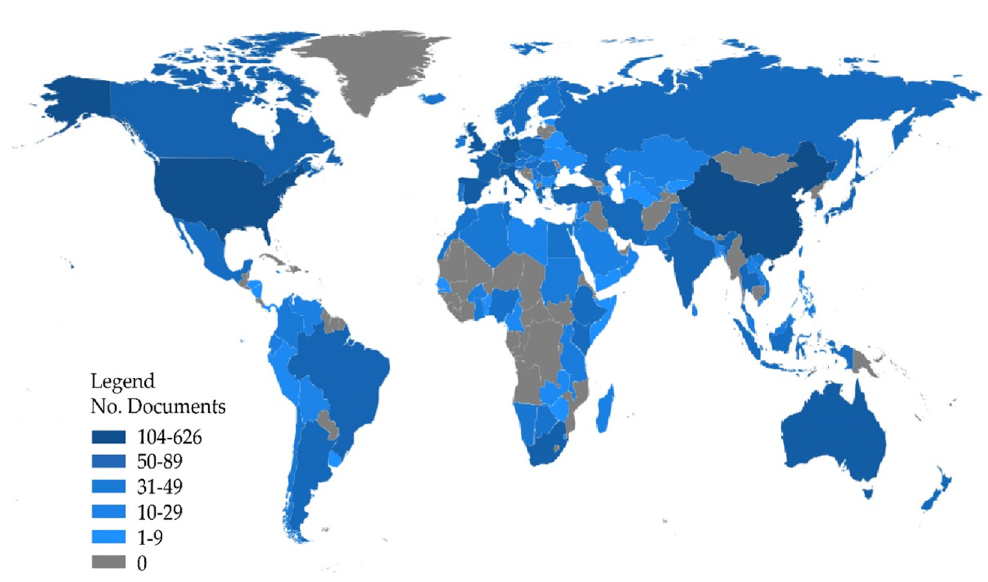
Figure 7. Scientific production distribution in the field of land